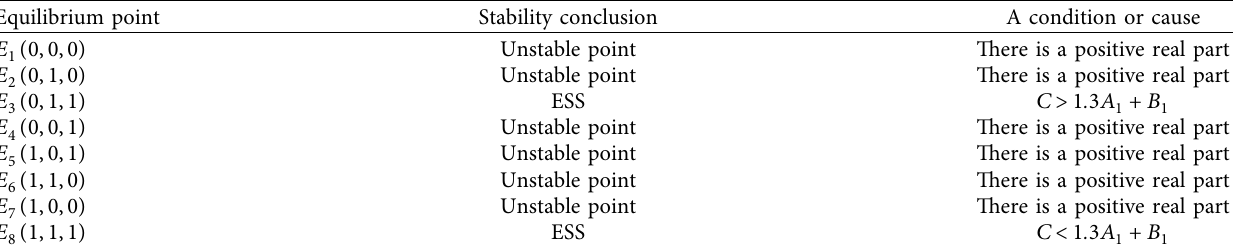
Table 4: Stability analysis of equilibrium